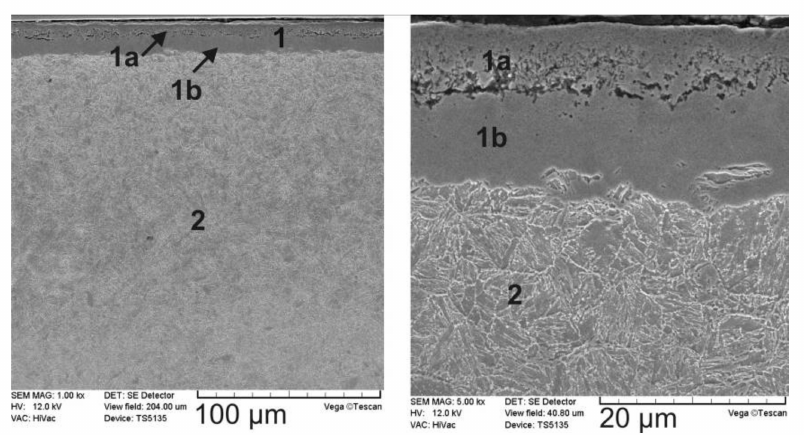
Figure 2. SEM images of gas-nitrided layer produced on 42CrMo4 steel: 1—compound zone; 1a—zone with ε nitrides; 1b—zone with ε + γ ’ nitrides; 2—di ff usion zone (nitric sorbite with γ ’